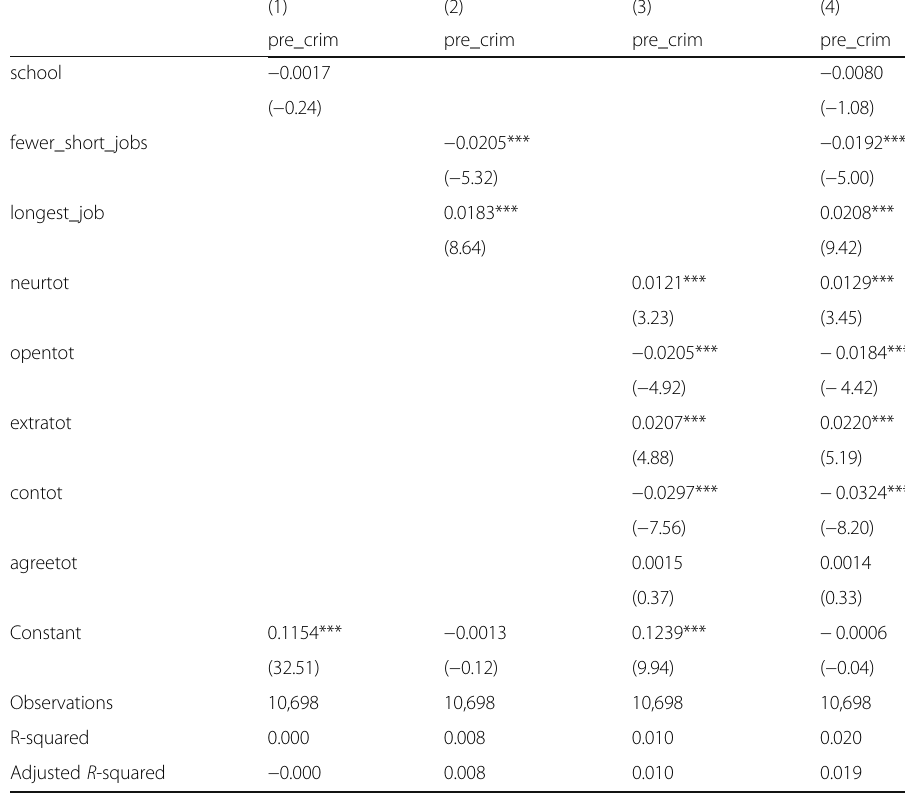
Table 18 Factor-level correlates of criminal background in hired population (customer service and sales) (1) (2) (3) (4) pre_crim pre_crim pre_crim pre_crim school − 0.0017 − 0.0080 ( − 0.24) ( − 1.08) fewer_short_jobs − 0.0205*** − 0.0192*** ( − 5.32) ( − 5.00) longest_job 0.0183*** 0.0208*** (8.64) (9.42) neurtot opentot extratot contot − 0.0297*** ( − 7.56) ( − 8.20) agreetot 0.0015 Constant 0.1154*** Observations 10,698 R-squared 0.000 0.020 Adjusted R -squared − 0.000 0.008 0.010